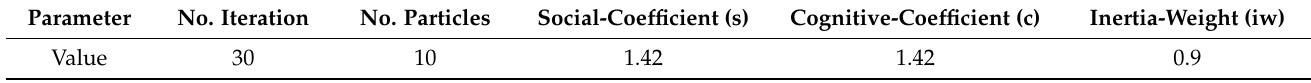
Table 3. The parameters of